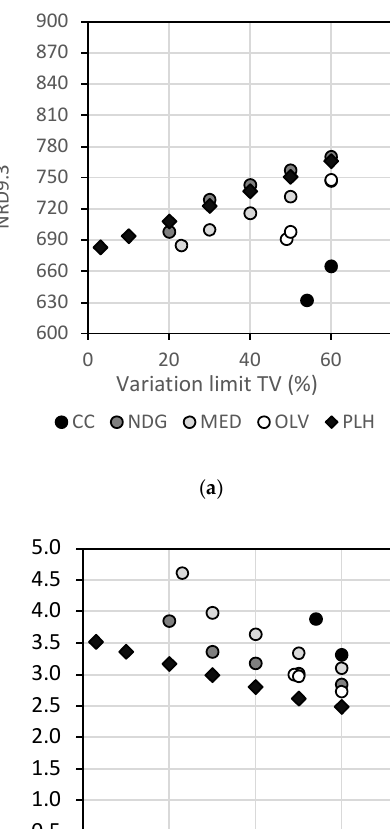
Figure A2. Pareto fronts of the multi-objective optimization of diets without constraints: ( a ) Constant economic index, ( b ) Constant environmental index, ( c ) Constant nutritional index.